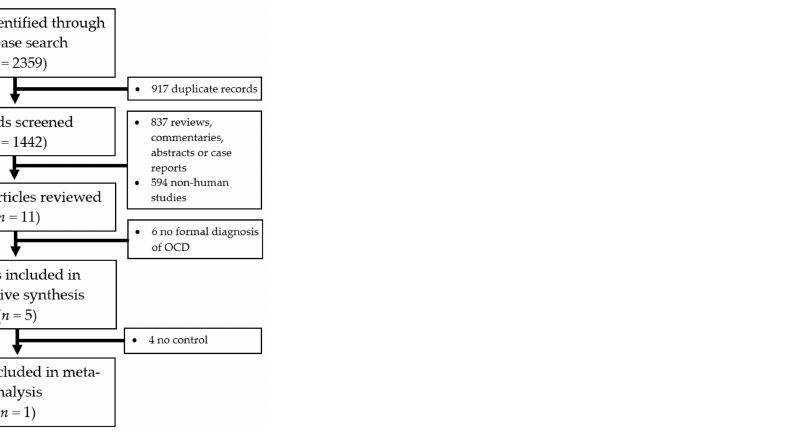
Figure 1. PRISMA flow diagram summarizing the studies identified during the literature search and abstraction